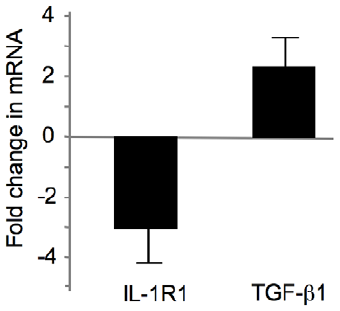
Figure 7. Expression of pro-inflammatory and anti-inflamma- tory cytokines in human OA cartilage. Total RNA was isolated from human cartilage samples obtained from early OA and late OA regions and the expression of target genes were analyzed by qPCR. Target genes in early OA were compared to late OA and expressed as fold induction. Values are mean 6 SD of 3 experiments per parameter per